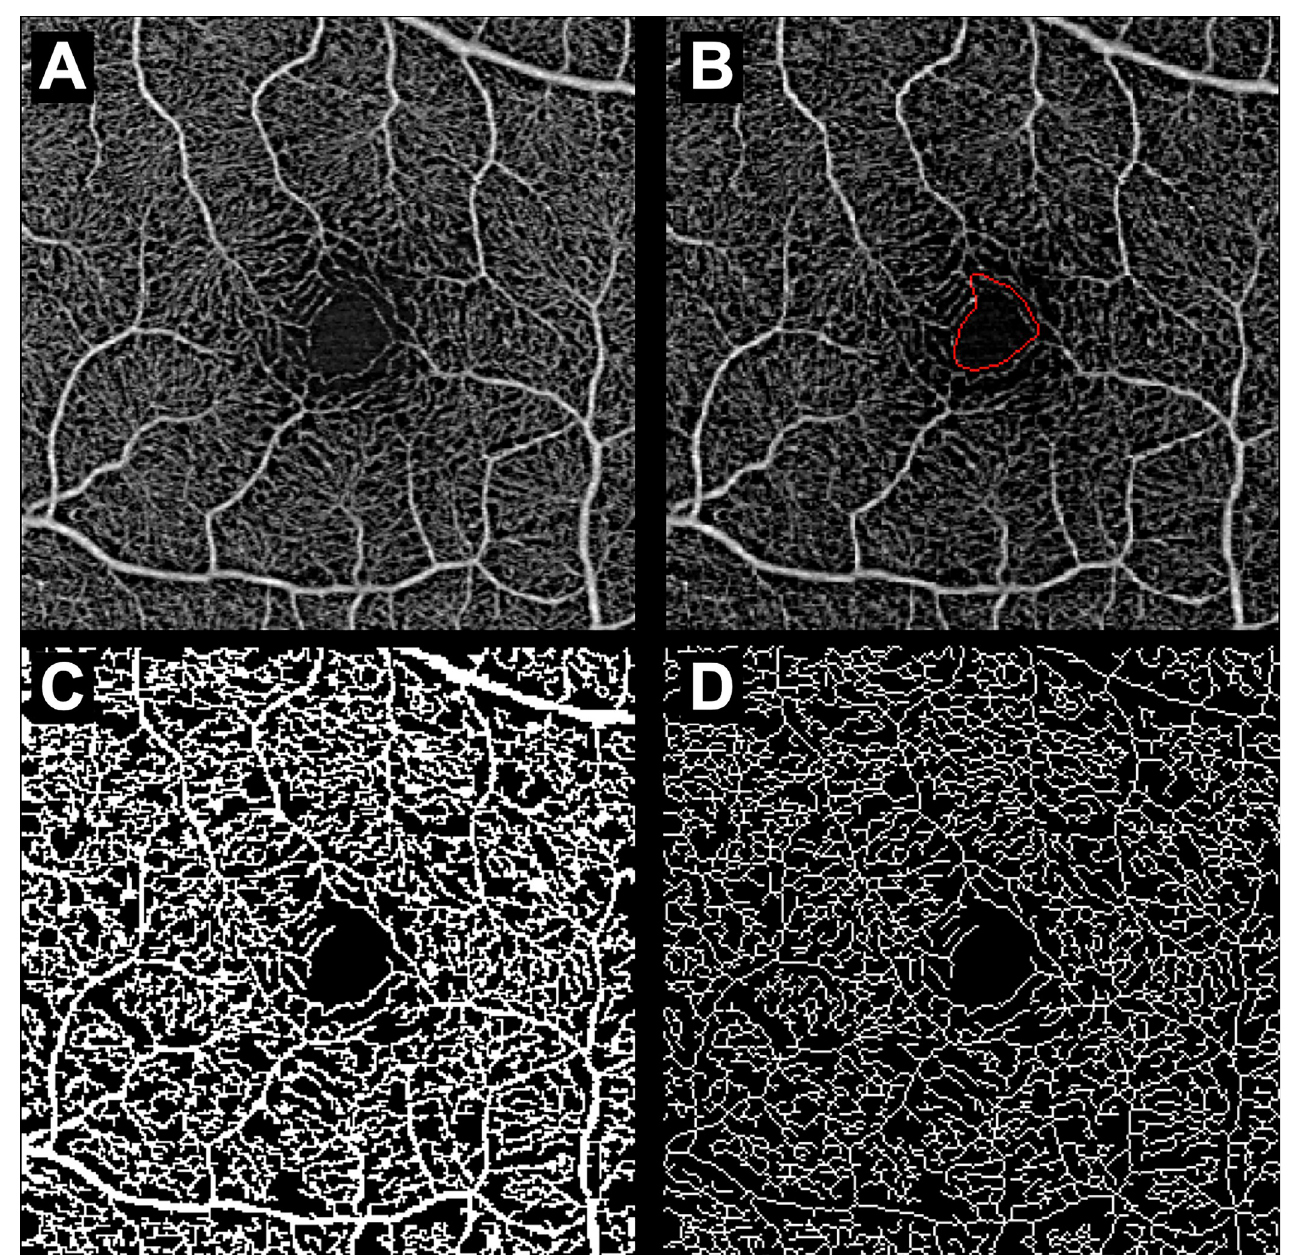
Fig 3. En face swept-source OCTA retinal images analyzed by Advanced Retina Imaging Network algorithms are shown. (A) The total retinal slab is shown. (B) Automated identification of the foveal avascular zone in the superficial retina is shown. (C) Automated identification of the superficial en face perfusion trace is shown. (D) Automated identification of the superficial en face vessel trace is shown. OCTA, optical coherence tomography angiography.